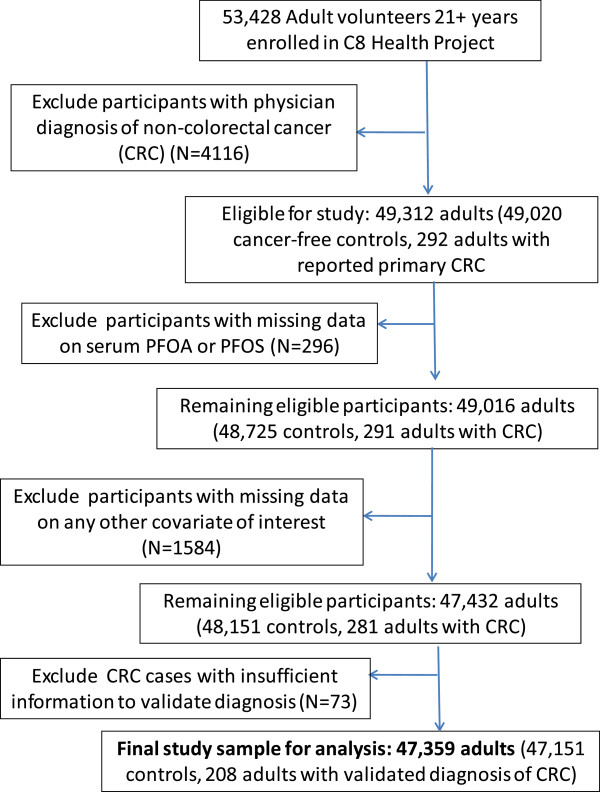
Study flow diagram.